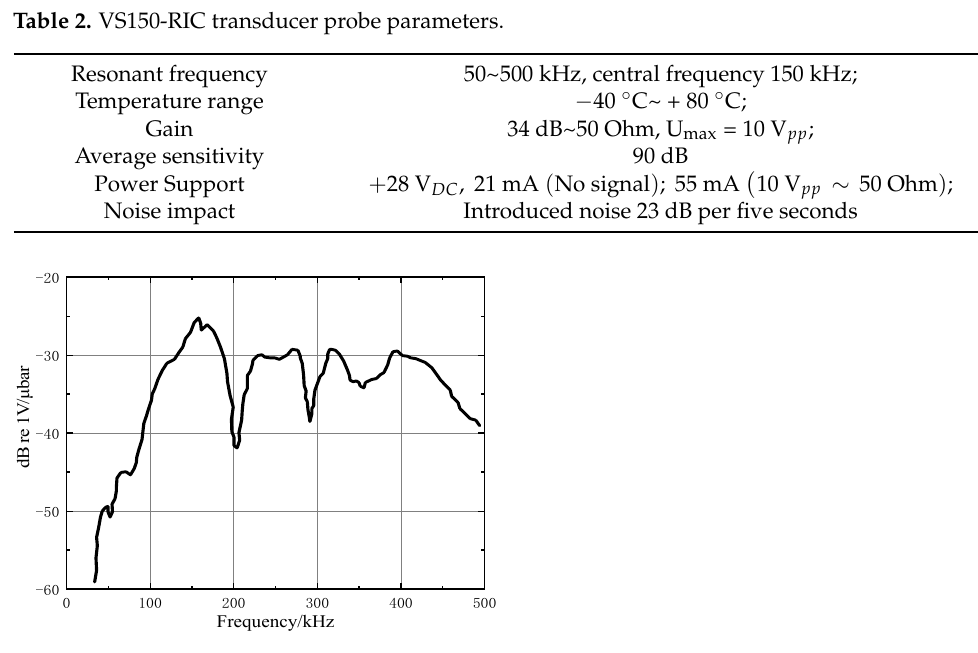
Figure 3. Resonant frequency response curve of VS150-RIC sensor probe.